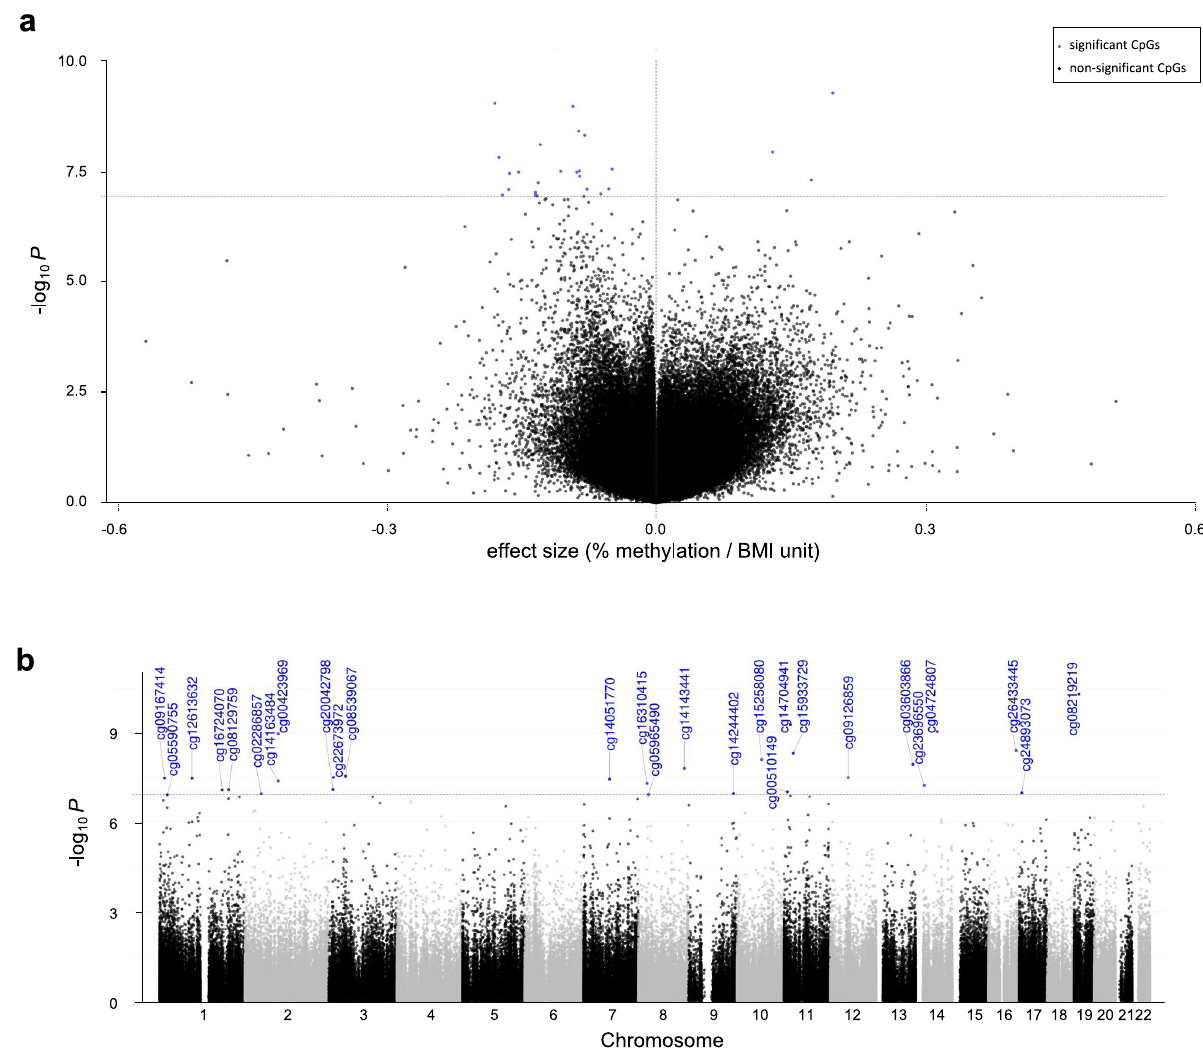
Fig. 2 Association between maternal ppBMI and placental DNAm ( N = 2631 placental DNA samples), after adjusting for maternal age, parity, maternal education, maternal smoking and putative cellular heterogeneity. Association results are displayed as a volcano plot, where the X-axis shows the effect sizes (ranging between 0 and 1) in DNAm and b Manhattan plot, where the X-axis represents the genomic location of each CpG. In both panels blue dots indicate signi fi cantly associated CpGs (meta-analysis p-value <